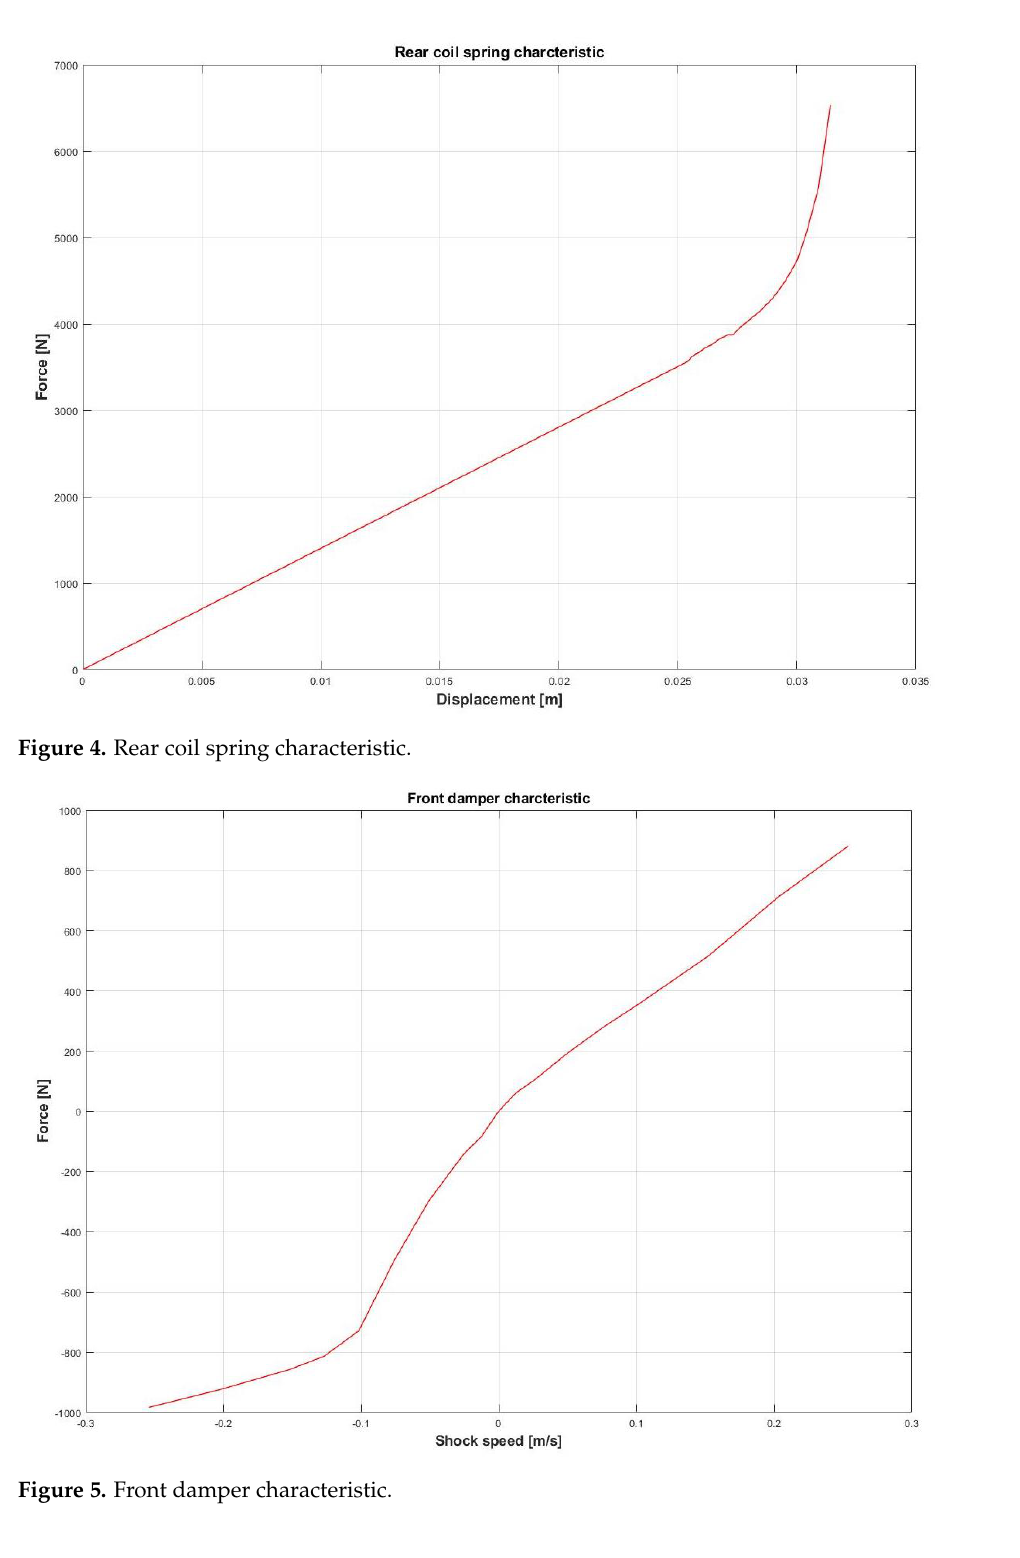
Figure 5. Front damper